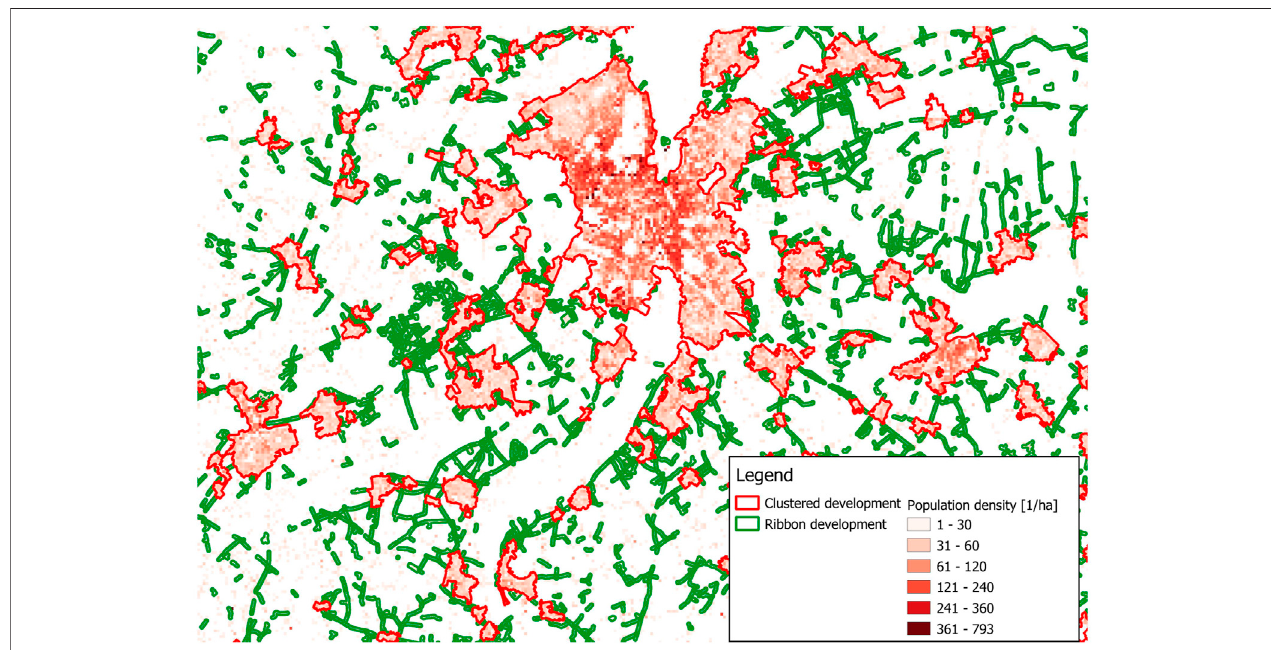
FIGURE 12 | Cluster and ribbon development linked with population